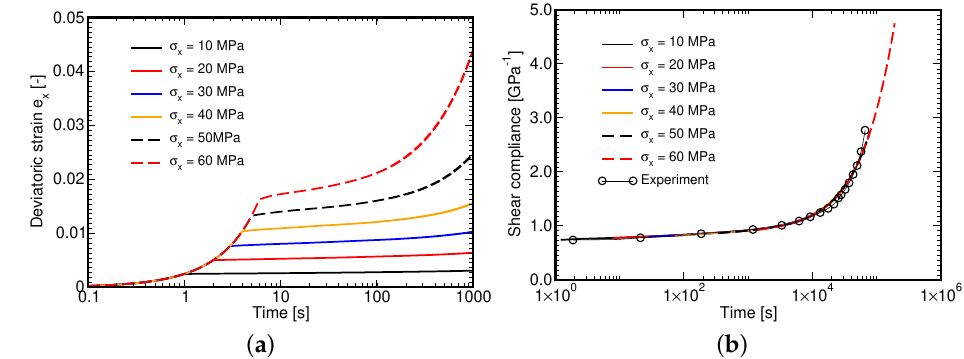
Figure 9. ( a ) Simulation of creep experiment, ( b ) Master curve derived from simulations.